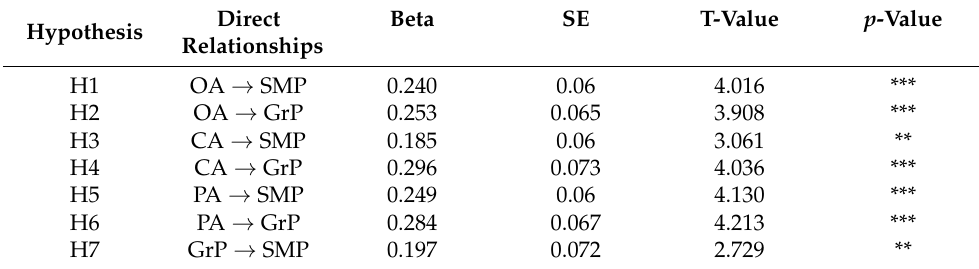
Table 4. Hypotheses Testing Direct